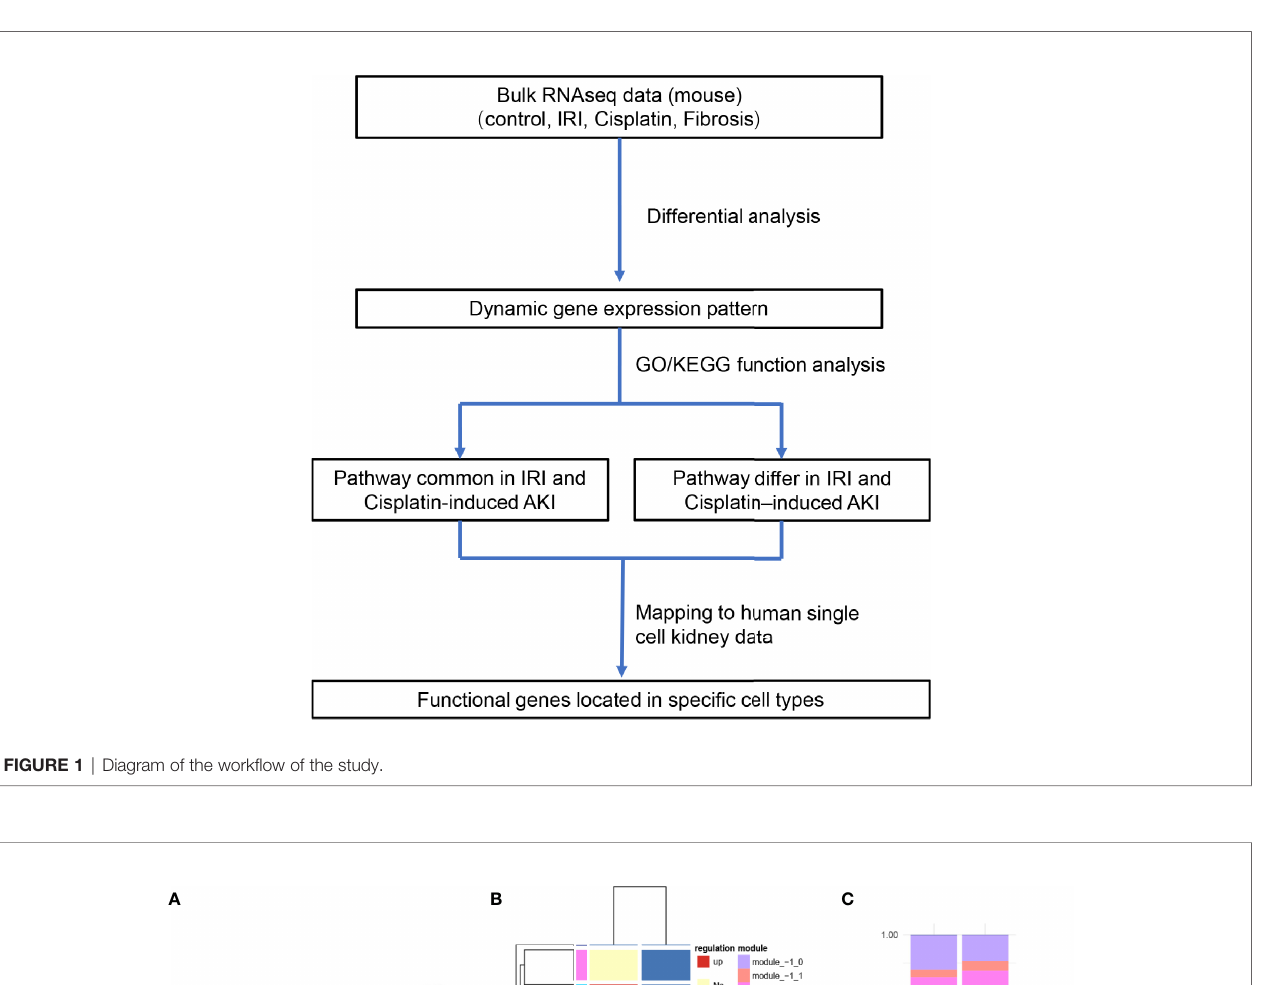
FIGURE 1 | Diagram of the work fl ow of the